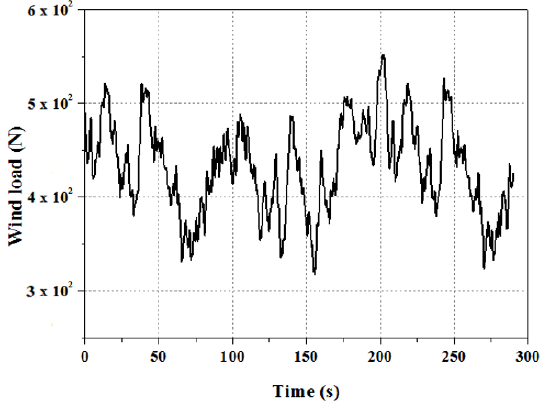
Figure 11. Simulation of the wind force time history.